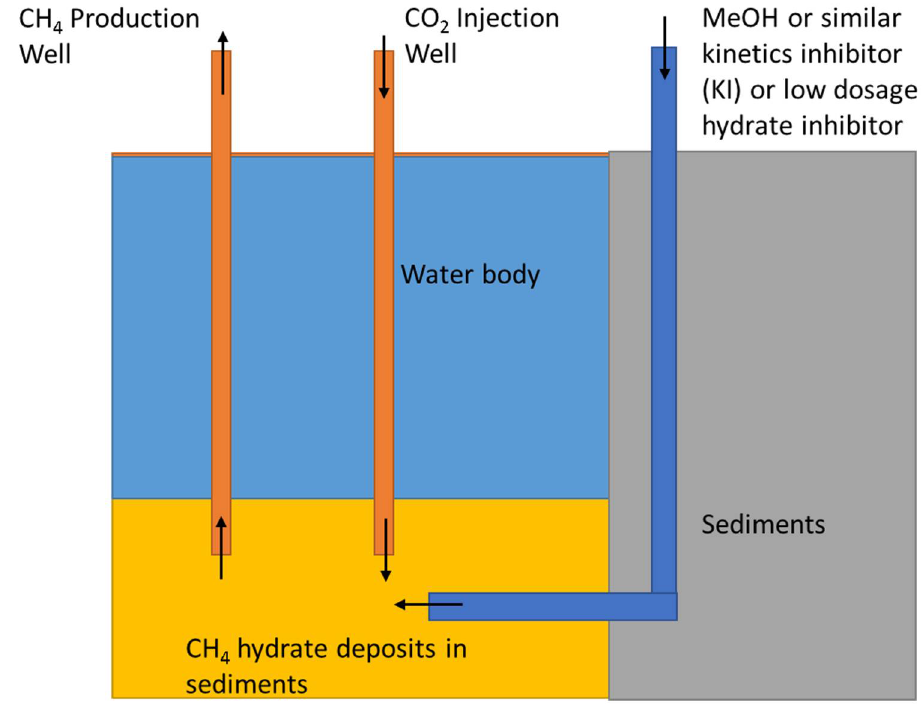
Figure 13. Conceptual schematic of additive-supported CO 2 injection into CH 4 hydrate for enhanced CH 4 -CO 2 hydrate swapping.